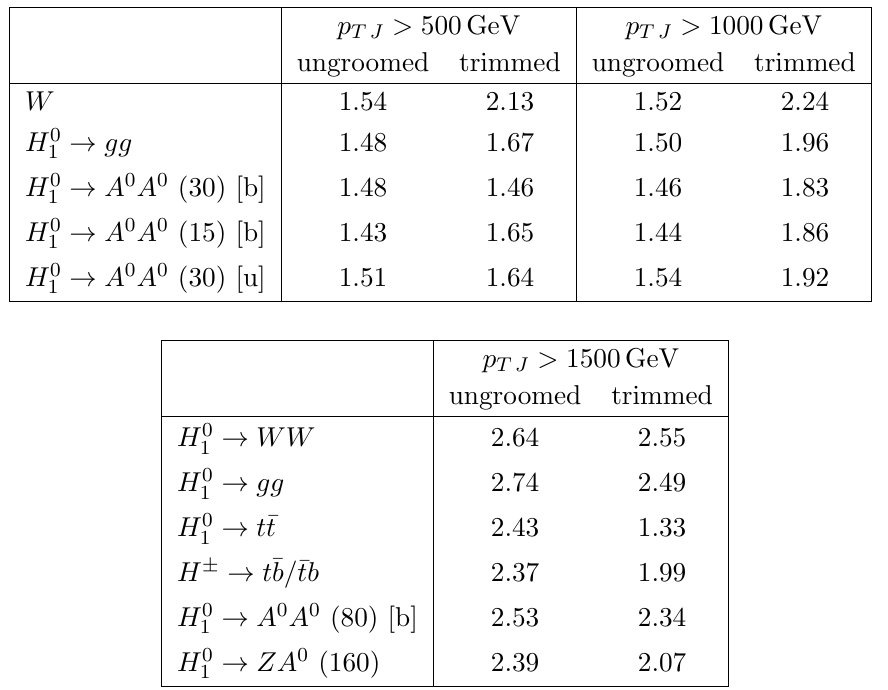
Table 2 . Enhancement of the signi(cid:12)cance S= p B due to the jet mass cuts m J m J [350 ; 450] GeV (bottom), with m J either the ungroomed or trimmed jet 2